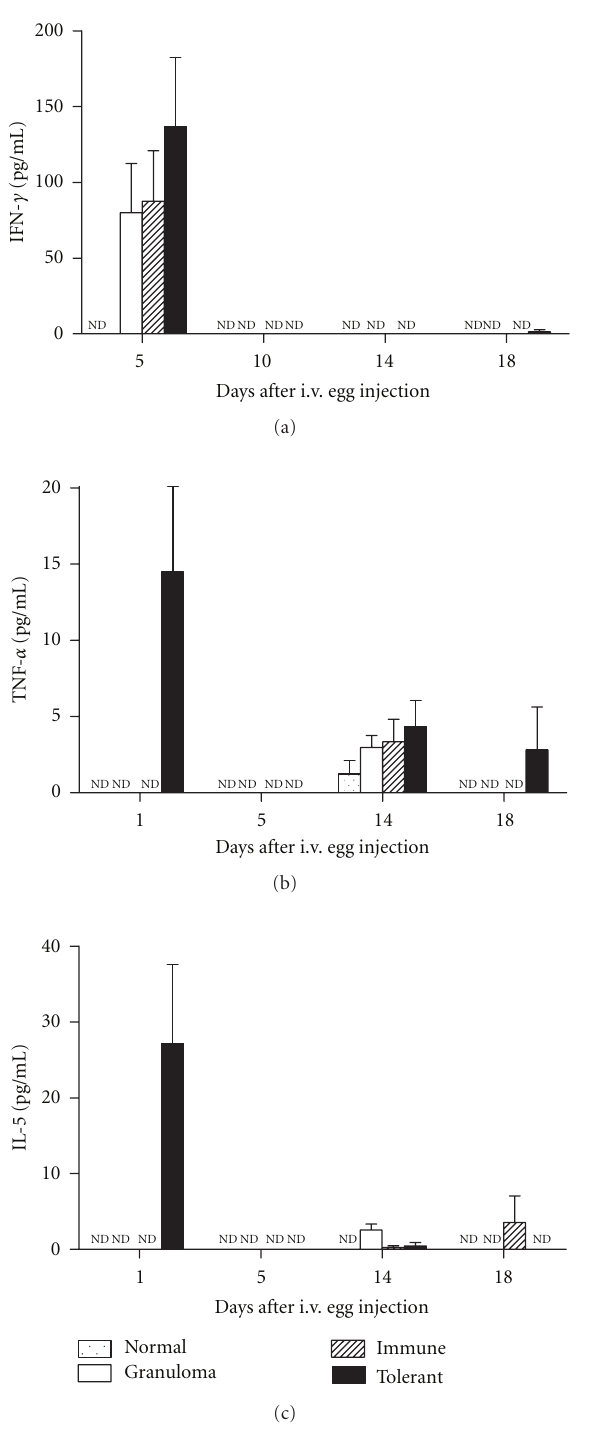
Figure 7: Time course of serum cytokines after granuloma induction. IFN- γ , TNF- α , IL-2, IL-4, and IL-5 were measured using a Cytometric Bead Array (CBA) kit in serum samples collected from nonimmunized mice (granuloma group, open bars), OVA immune controls (hatched bars), and OVA-orally tolerant mice (black bars). Normal mice (doted bars) were not immunized with OVA and neither injected with eggs. The results are shown as mean concentrations ± SEM. nd: not detected. IL-2 and IL-4 were not detected.